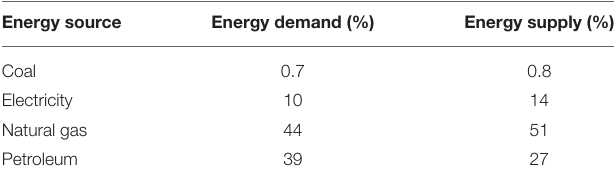
TABLE 1 | Energy Demand and Supply Share in Pakistan for the period 1980–2012 3